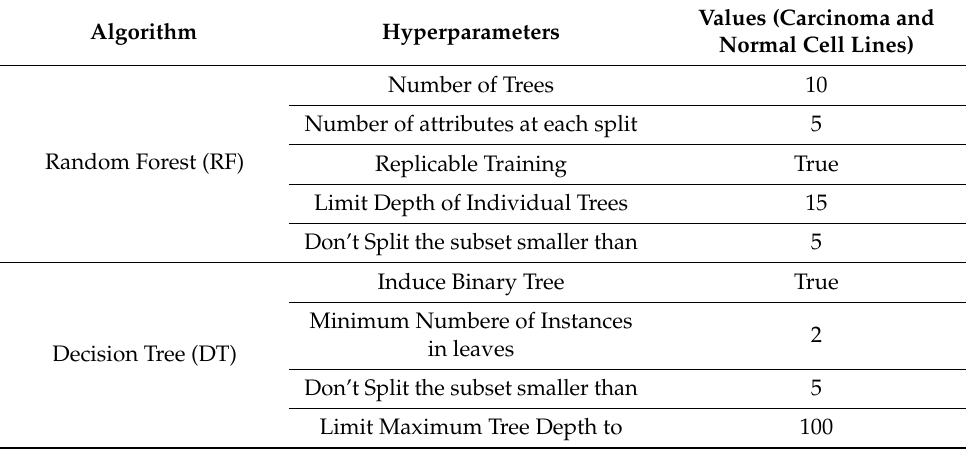
Table 1. Represents the hyperparameters utilized for the algorithms.